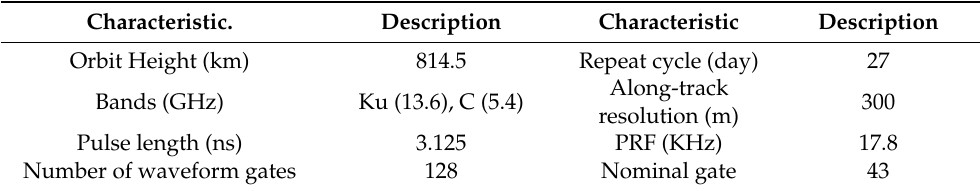
Table 1. Characteristics of Sentinel-3A mission